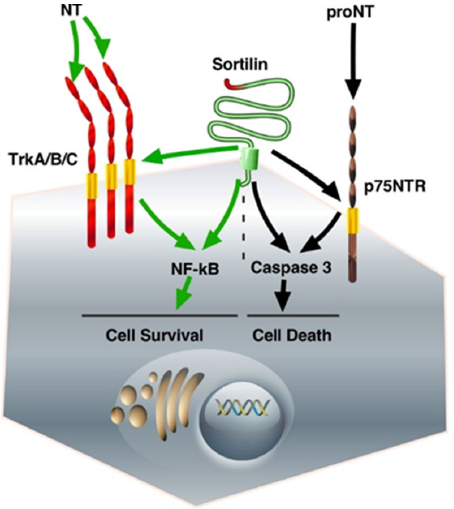
Figure 1. The fate of neurotrophin receptors/Sortilin interactions. The binding of proNT to the complex Sortilin/p75NTR triggers intracellular pathways that activate caspase 3, leading to cell death. On the other hand, the binding of matured NT to Trk receptors is responsible for NF-kB activation, which induces cell survival. The abbreviations used are: Trk, Tropomyosin Receptor Kinase; NT, neurotrophin; proNT, neurotrophin precursor; p75NTR, p75 neurotrophin receptor; NF-kB, nuclear factor kappa ‐ light chain enhancer of activated B cells.